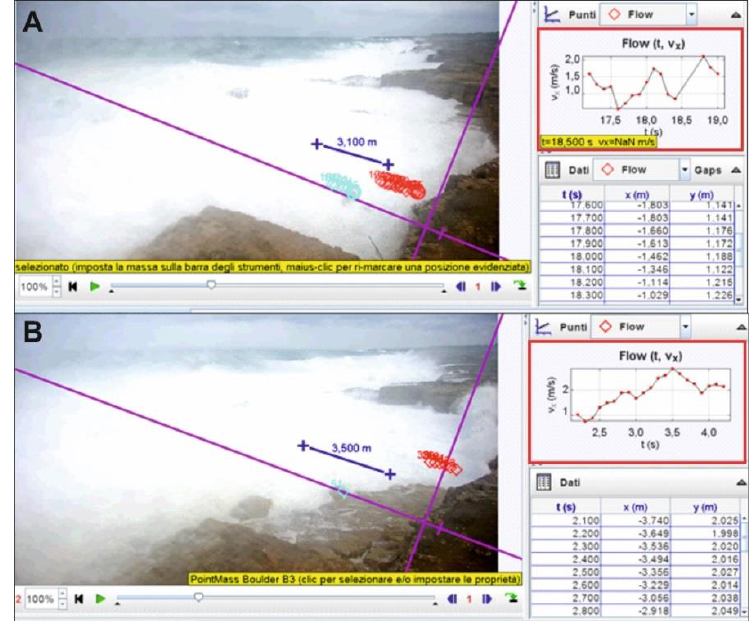
Figure 8. Editing analysis of video frames during boulder movements through Tracker software. ( A ) Rolling of boulder B2 at hour 15:02:00 UTC; ( B ) movement of boulder B3 at hour 16:16:00 UTC. In the red box diagrams are showed the flow velocity estimations marked for each frame of the video. Table 3. Boulderdetectedbyvideoediting,selectedforflowvelocitycomparisonwithhydrodynamicmodels.